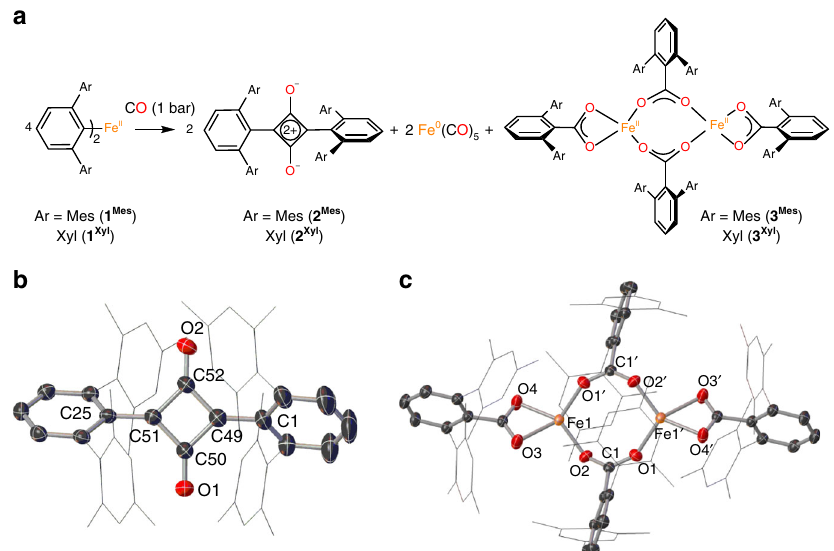
Fig. 1 The reductive coupling and functionalisation of CO by iron(II) diaryls 1 Mes and 1 Xyl . a General scheme for the reaction between CO and iron(II) diaryls 1 Mes or 1 Xyl . b The molecular structure of 2 Mes with anisotropic displacement ellipsoids set at 50% probability. Mesityl groups shown as wireframe, hydrogen atoms and one molecule of hexane solvent are omitted for clarity. c The molecular structure of 3 Mes with anisotropic displacement ellipsoids set at 50% probability. Mesityl groups shown as wireframe and hydrogen atoms have been omitted for clarity. Selected bond distances (Å) and angles (°) for 3 Mes : Fe1 – O1 1.9736(11), Fe1 – O2 1.9357(11), Fe1 – O3 2.1909(13), Fe1 – O4 2.0232(12), O1 – Fe1 – O2 109.30(5), O3 – Fe1 – O4 61.77(5)